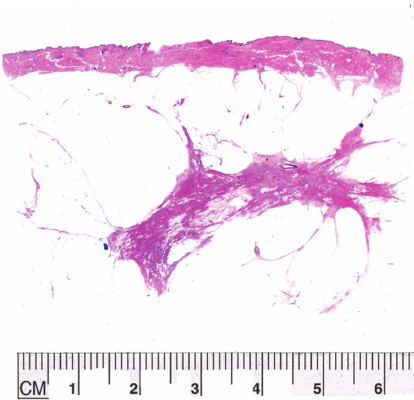
Figure 4: An example of “scatter regression” of tumor after neoadjuvant chemotherapy. She started with a 5cm intermediate grade (6/9 MBRS) invasive ductal carcinoma. At the end of treatment the “tumor bed” with scattered foci of viable tumor cells involved an area of 4.7 cm represented by the irregular scar (density).